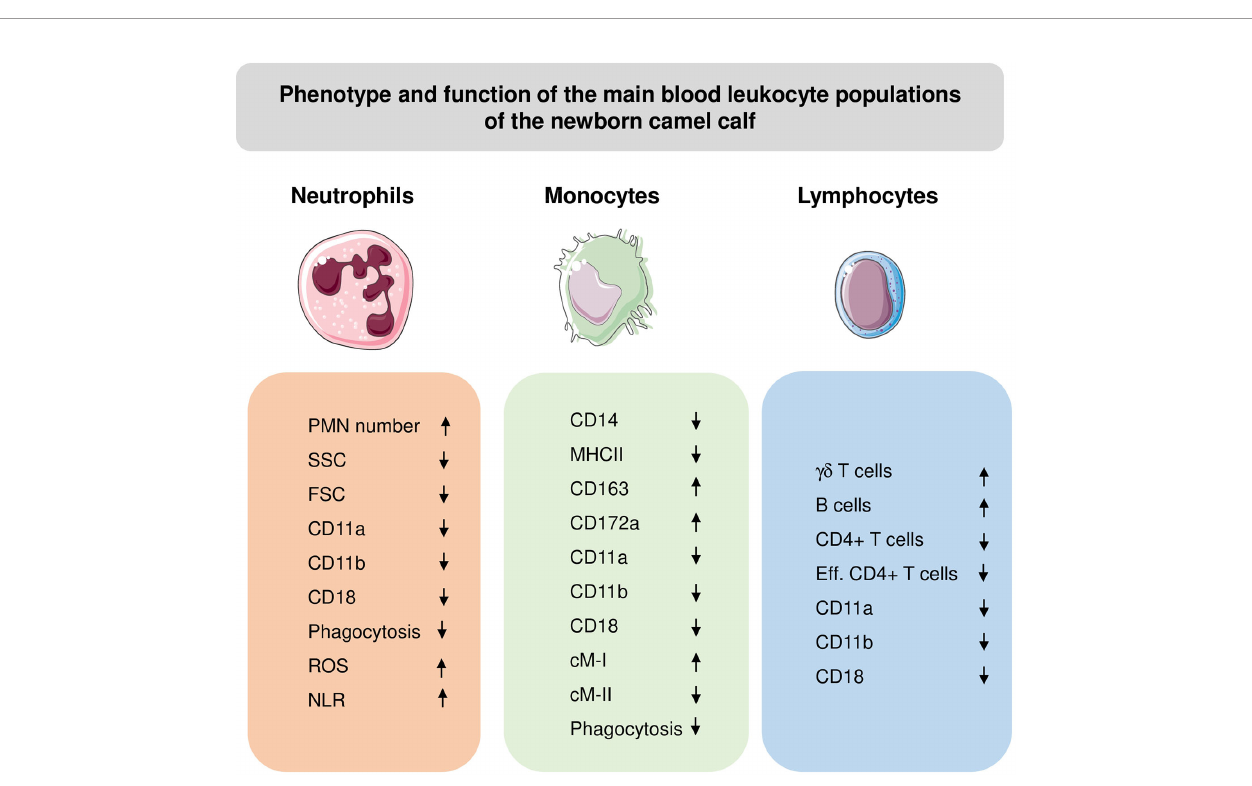
FIGURE 4 | Phenotypic and functional properties of neutrophils (PMN), monocytes, and lymphocytes in blood of newborn camel calves. ROS, Reactive Oxygen Species amount in unstimulated cells; NLR, Neutrophil to lymphocyte ratio; Eff, effector cells. The direction of the arrows indicates higher (up arrow) or lower (down arrow) values for calves compared to